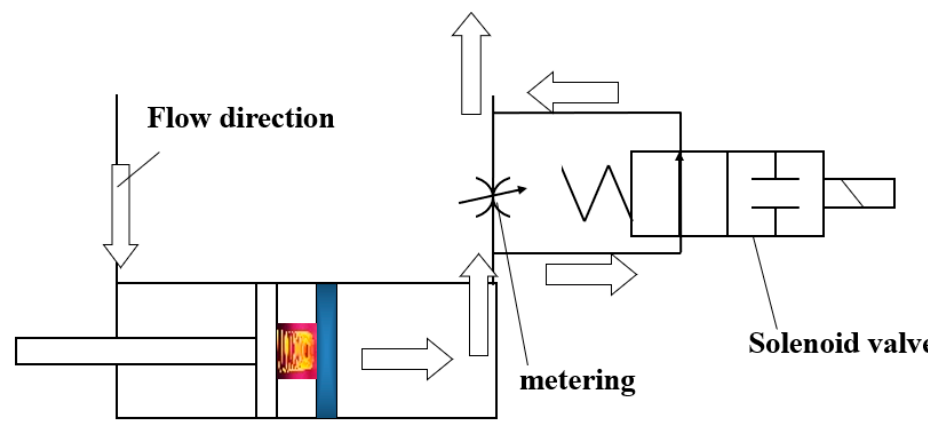
Figure 5. Pneumatic circuit diagram (when unshocked).